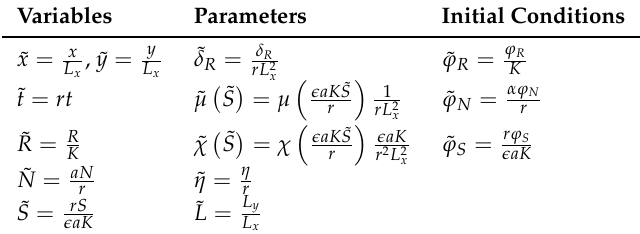
Table 3. Dimensionless variables and parameters of model